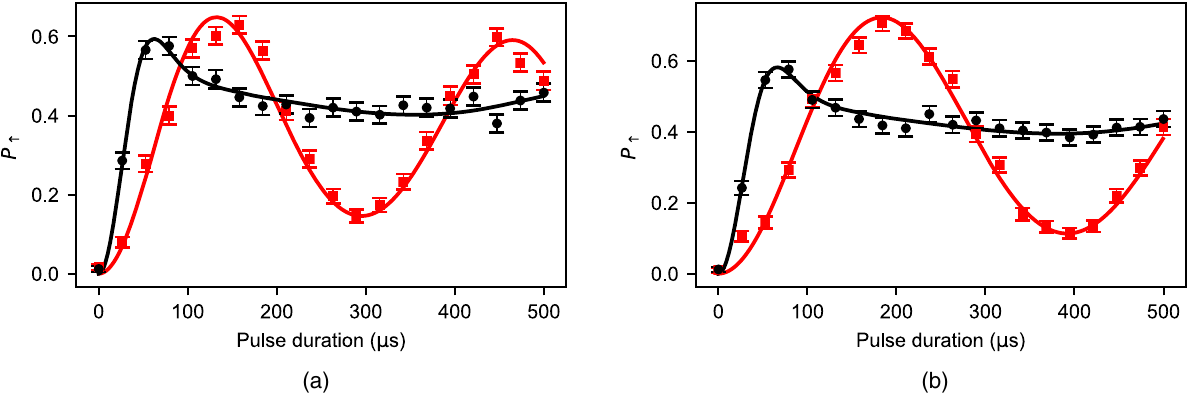
FIG. 8. Probability of exciting the HCI to the excited state P ↑ ð t Þ by driving the first blue sideband of the (a) x and (b) y WCR modes, observed on the HCI as a function of interrogation time before (black) and after (red) algorithmic cooling to the ground state was applied. The clean Rabi flopping behavior visible after cooling is a clear indication of a high population in the vibrational ground state of both radial in-phase modes. Details of the fitting function are given in the